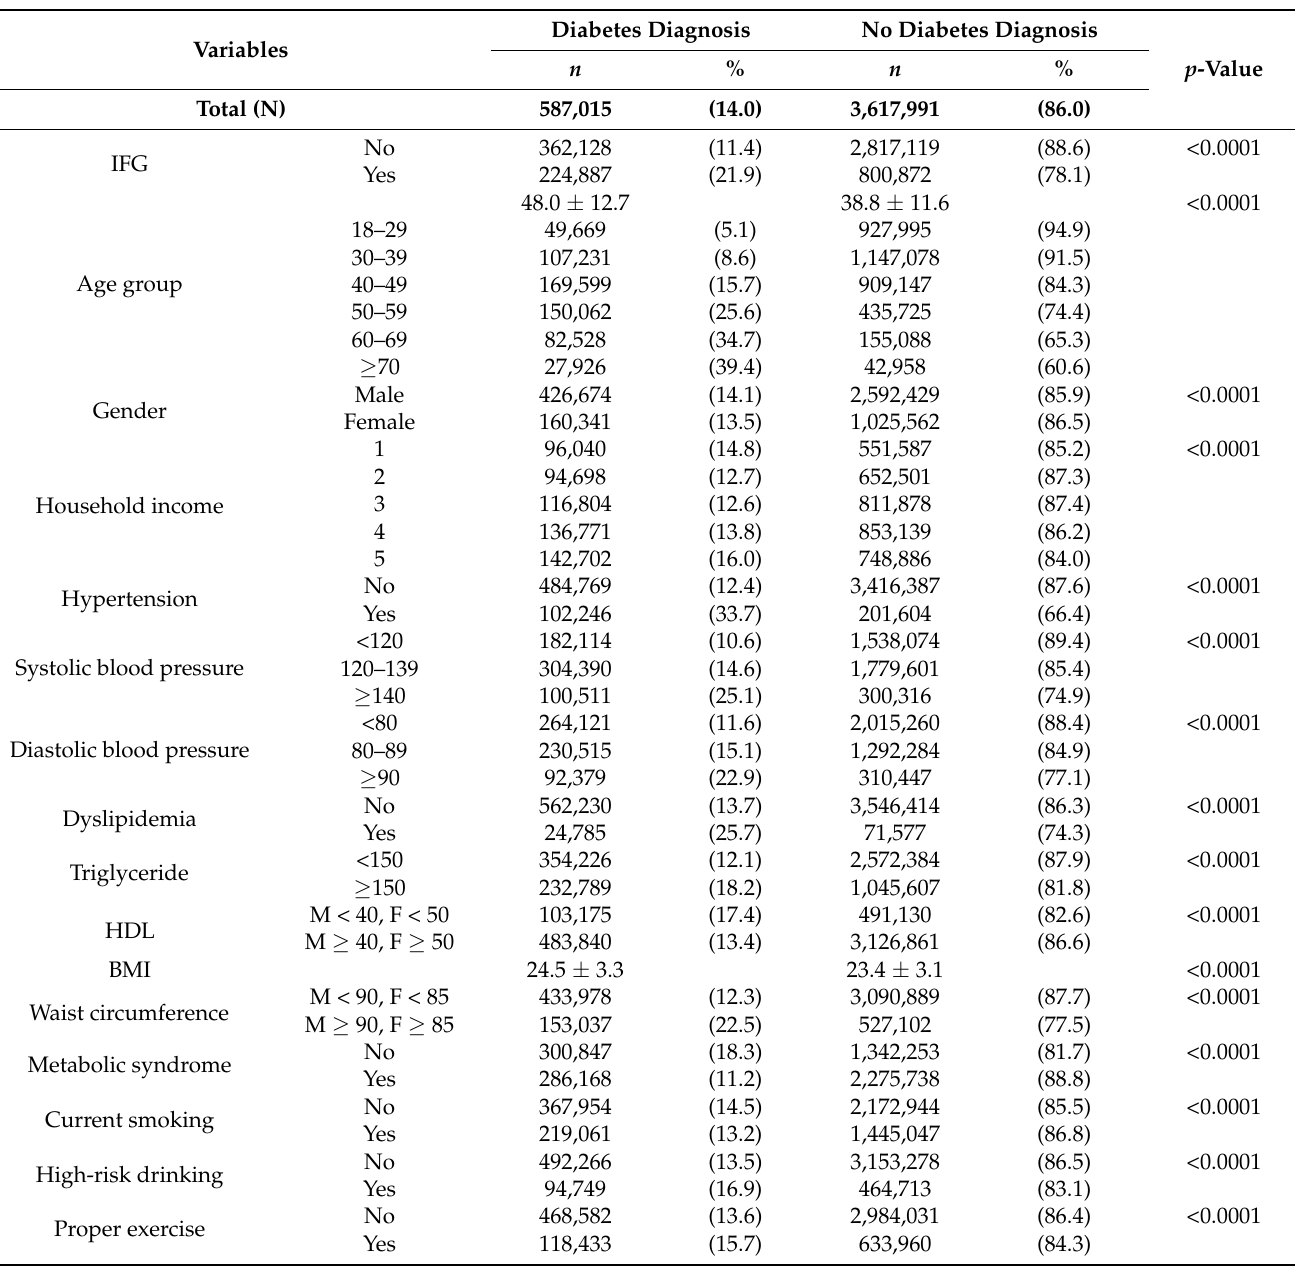
Table 3. Characteristics of the progression from non-diabetes to